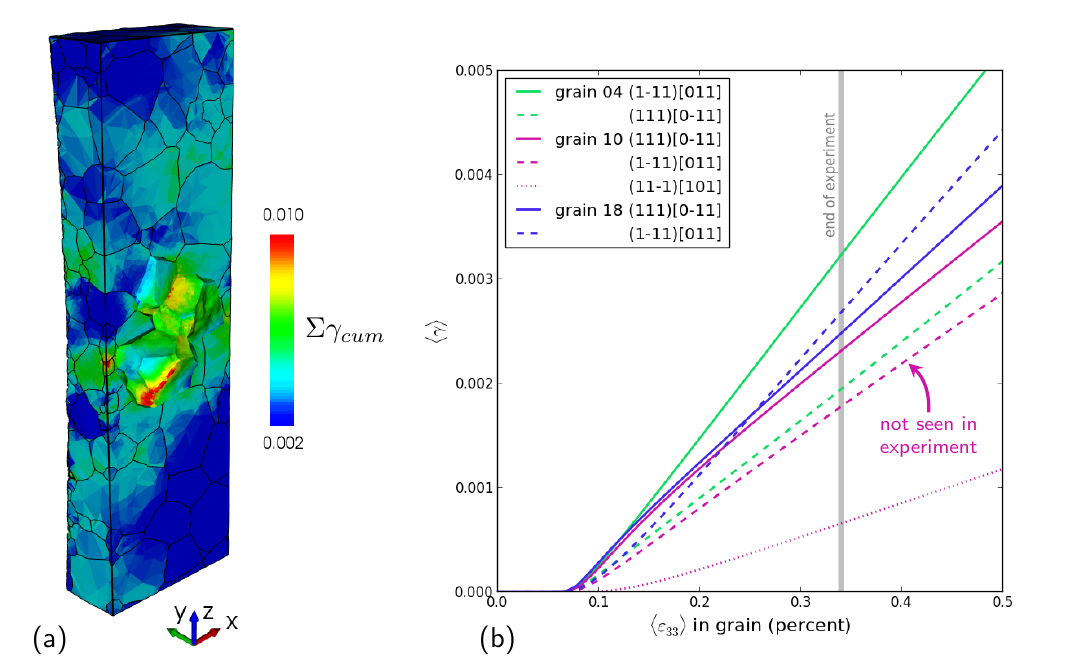
Figure 9. Predicted plastic activity: ( a ) view of the interior of the specimen showing the accumulated plasticity at the load level corresponding to the end of the experiment; ( b ) average plastic activity in the three grains of the cluster; the most active slip system is represented with a solid line and the second most active with a dashed line, while the grain color code is